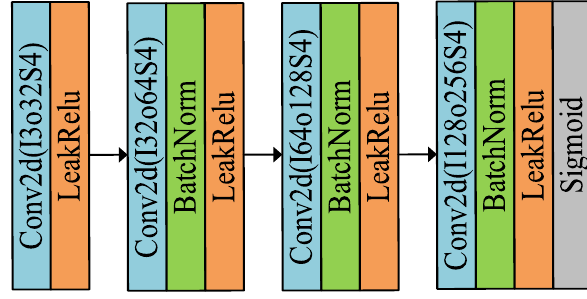
Figure 9. Discriminator architecture diagram.